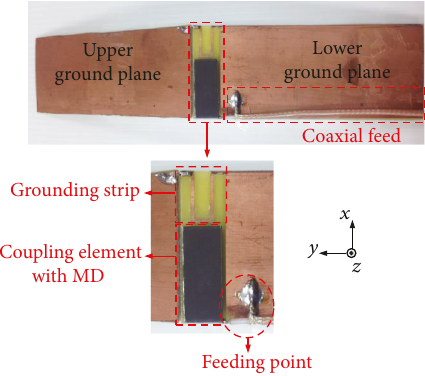
Figure 11: Photograph image of the MD-loaded MLA